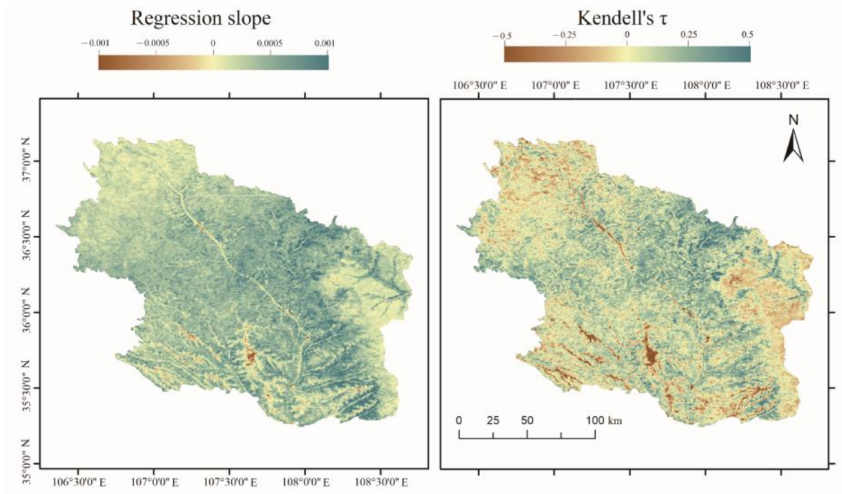
Figure 7. Linear regression slope and Kendall’s τ ( p < 0.001) derived from monthly FVC between 2000 to 2019.